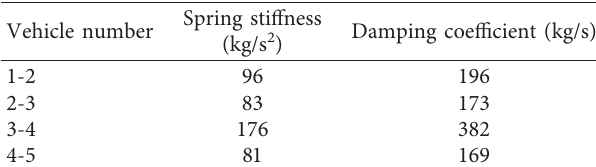
Table 2: MSD system parameters.